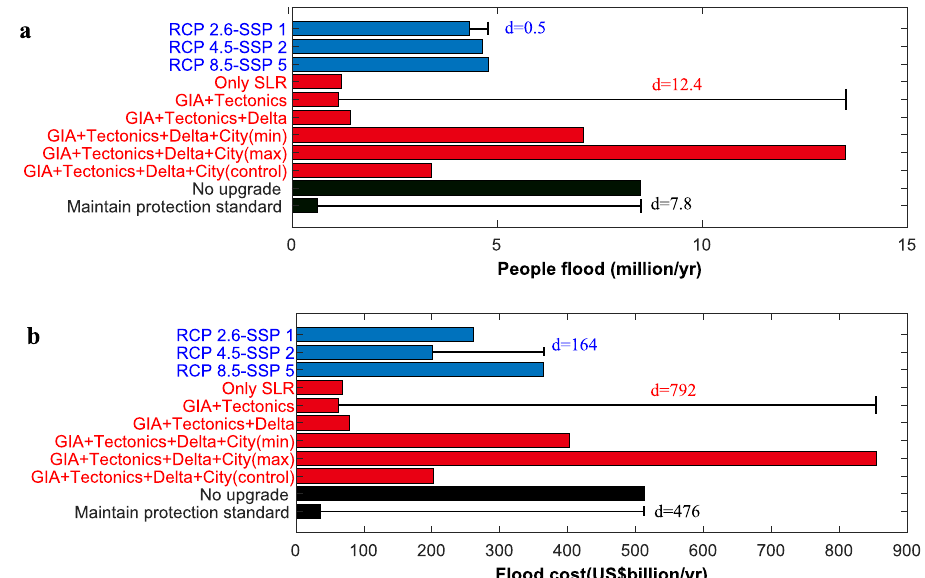
Fig. 4 | Sensitivity ofimpacts in 2050 to the uncertainty dimensions considered. a People fl ooded; b Flood cost. Sensitivity iscalculated as the average difference (d and error bars) between the impacts by modifying one input variable while holding the other dimensions